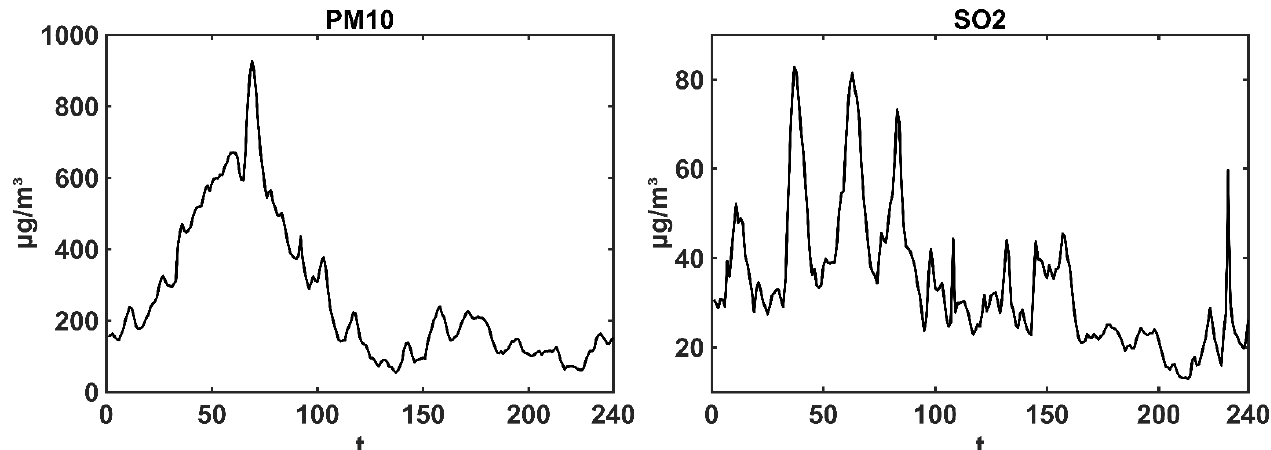
Figure 2. Hourly average NO 2 , CO, O 3 , PM 10 , PM 2.5 and SO 2 data of Zhengzhou over the period from 24:00 17 December 2016 to 23:00 26 December 2016 (240 h).